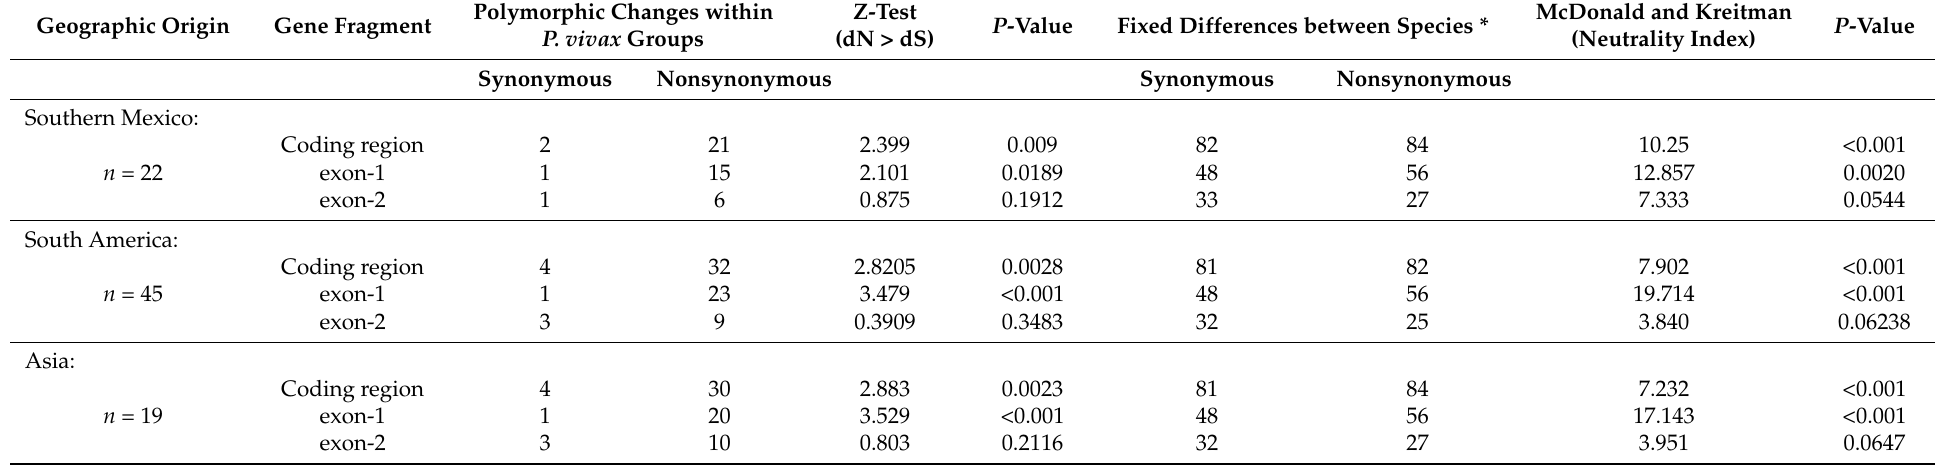
Table 5. Selection tests for the P. vivax cyrpa coding gene among different parasite